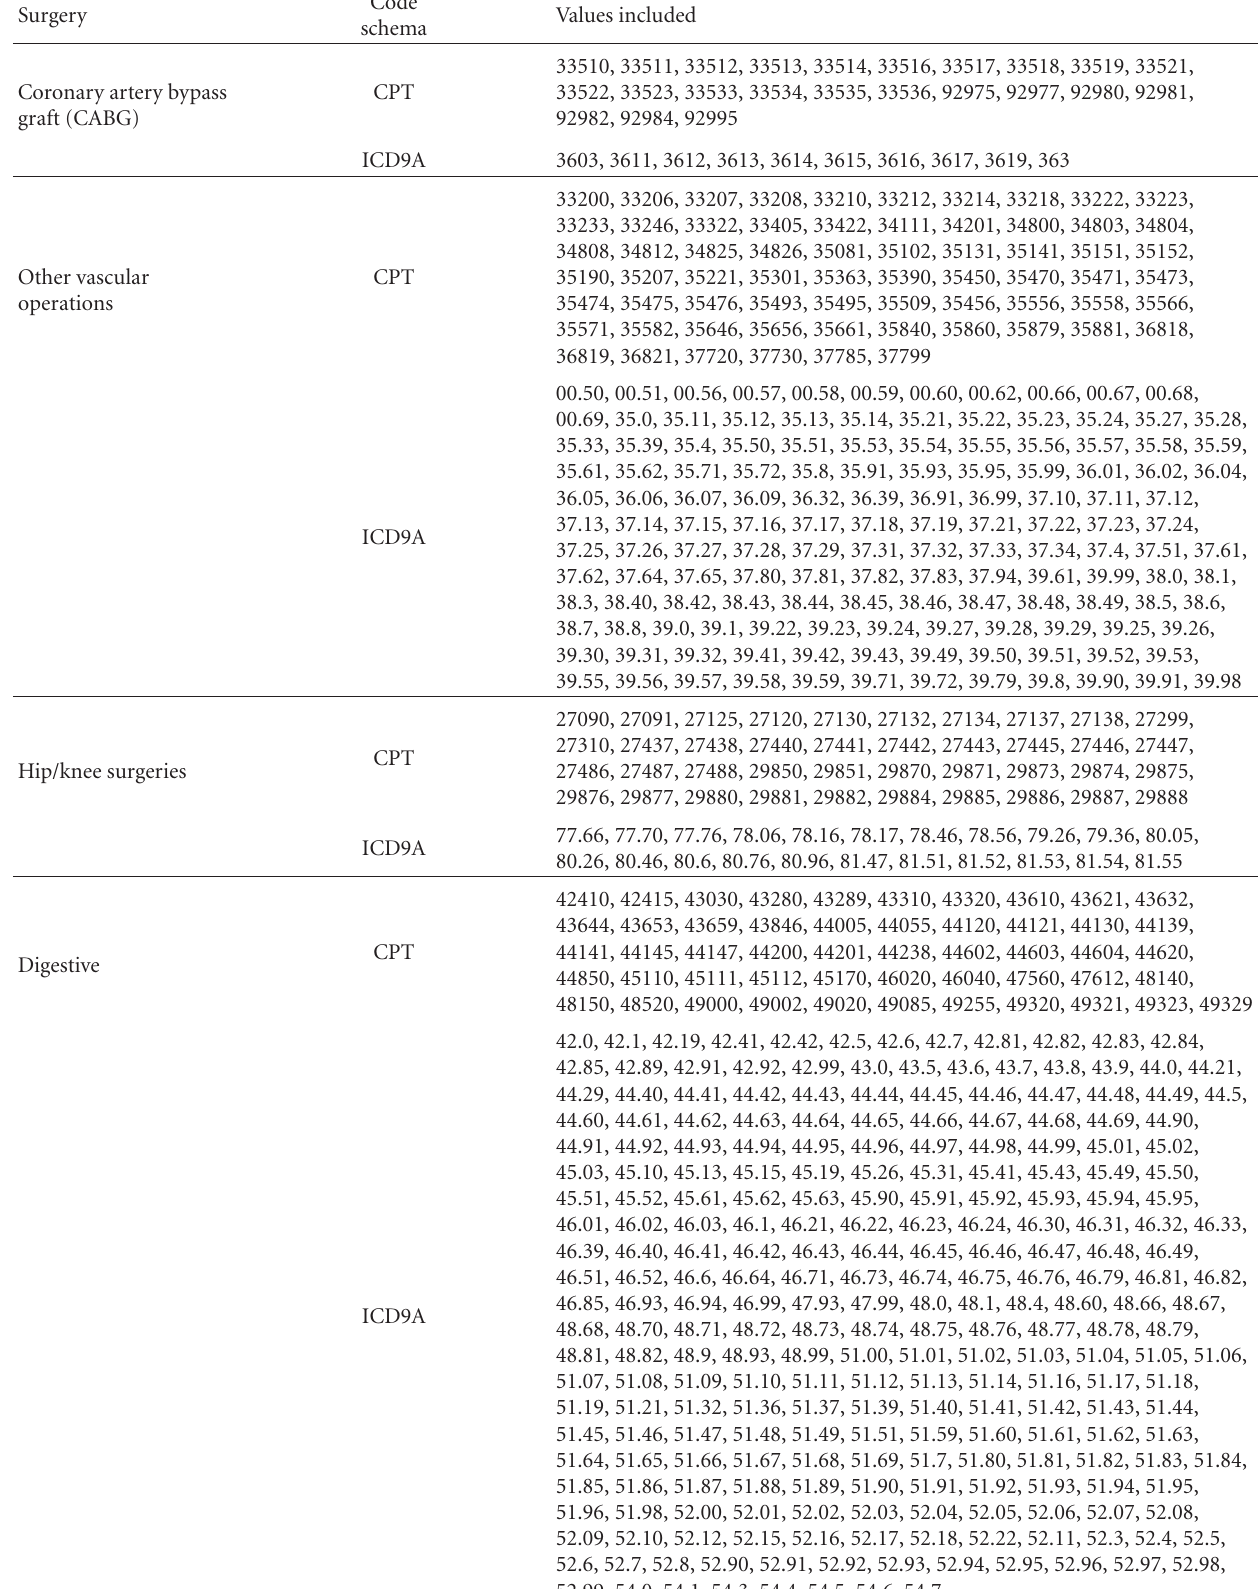
Table 1: Definitions of four common types of